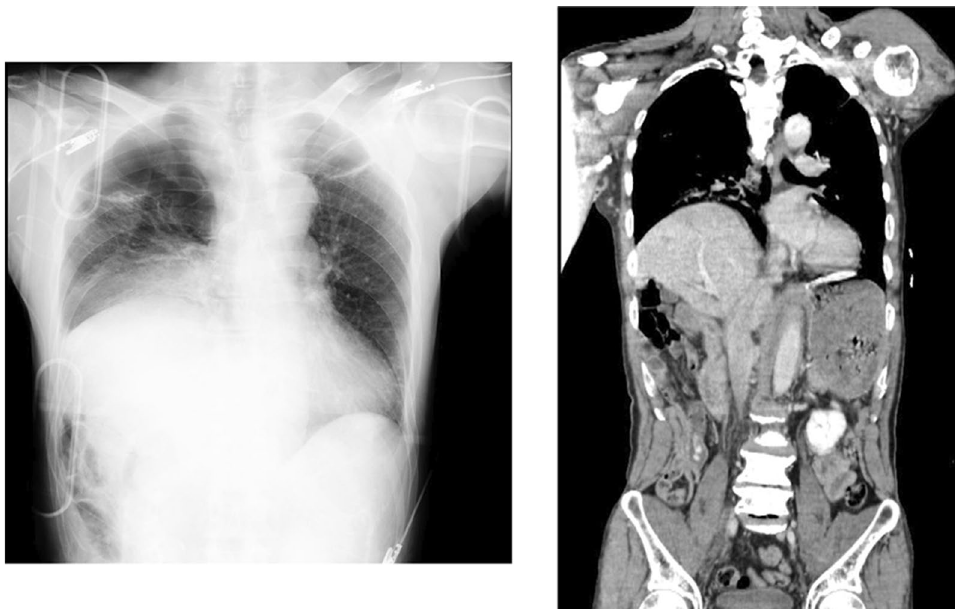
Fig. 1 Chest X-ray and CT scan findings on the day of admission. The enhanced CT scan and chest X-ray shows right diaphragm elevation and pulmonary